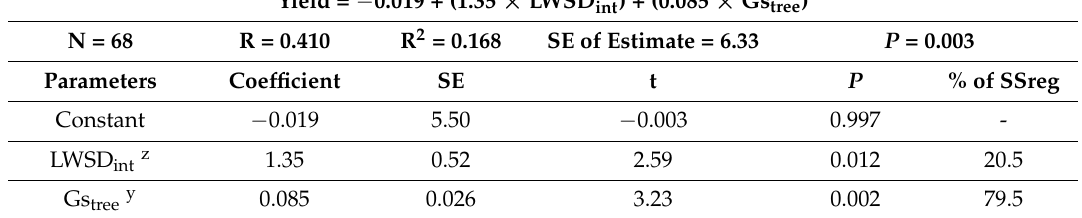
Table 4. Multiple linear regression model and parameters contributing to predict yield in ‘Gala’ apple trees under deficit irrigation.